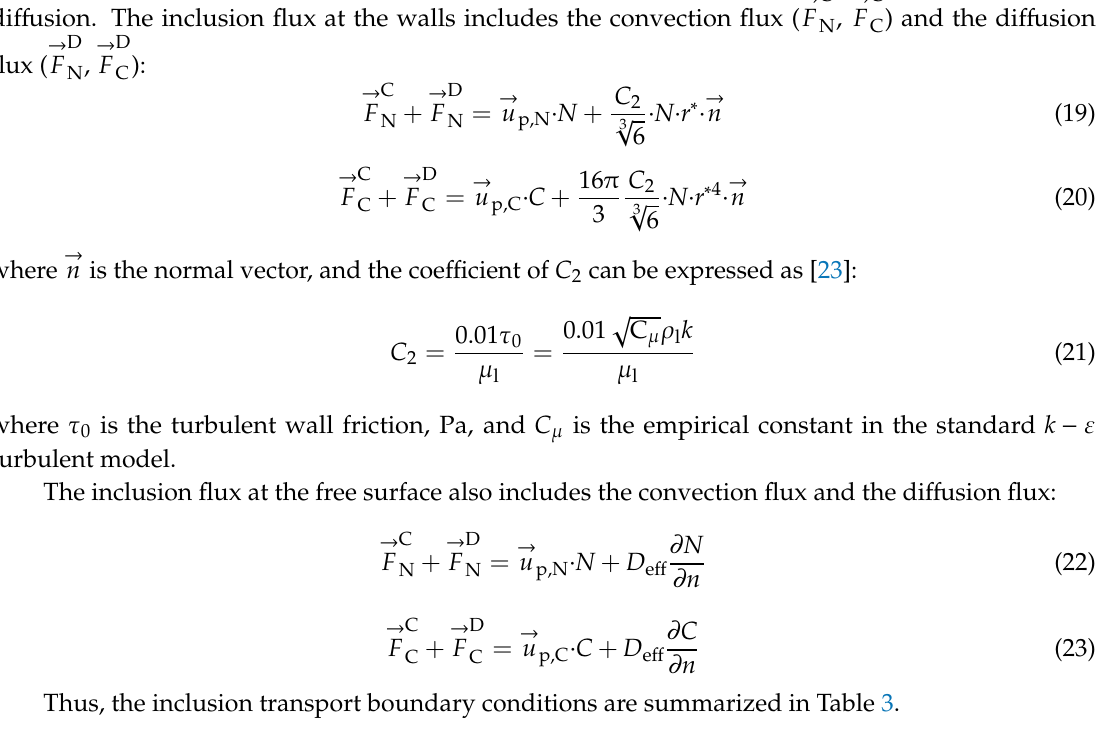
Table 3. Boundary conditions for inclusion